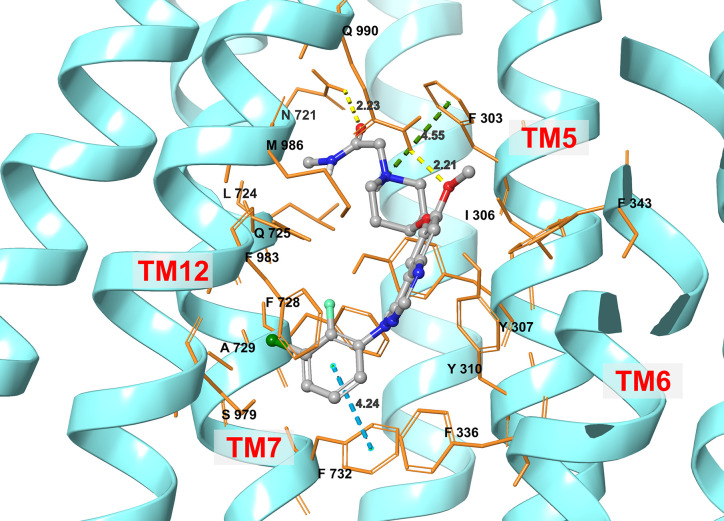
An illustration of the interaction between sapitinib and the human ABCB1 transporter protein based on docking analysis.